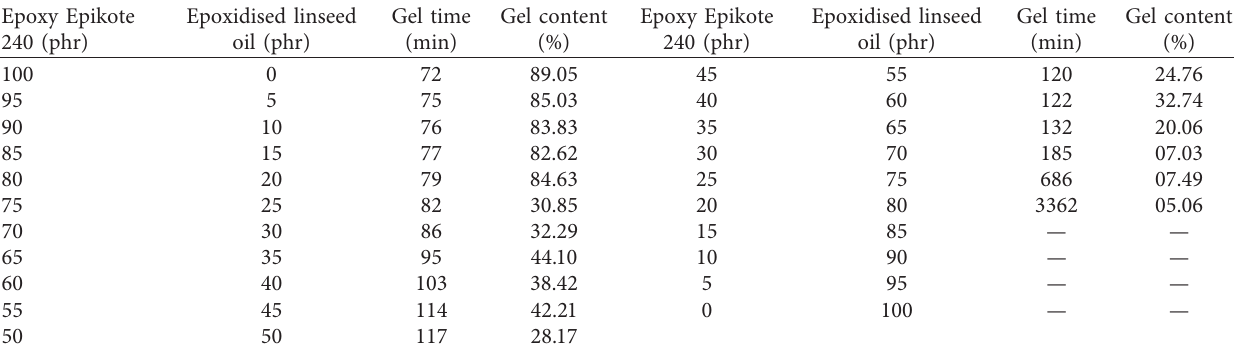
Table 1: Level curing and time curing of the blend